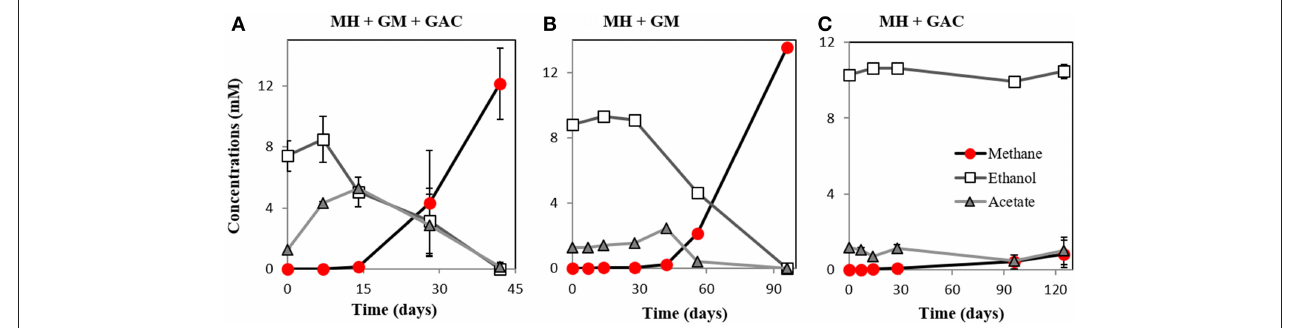
FIGURE 6 | Co-culture experiments with M. horonobensis and G. metallireducens . M. horonobensis established successful co-cultures with G. metallireducens as apparent from ethanol utilization and methane production in the presence ( A , n = 3) or absence of GAC ( B , n = 1; see replication in Figure S6 ). Alone, M. horonobensis could not utilize ethanol or produce methane in the presence of GAC ( C , n = 3). MH, Methanosarcina horonobensis ; GM, Geobacter metallireducens ; GAC, granular activated carbon.